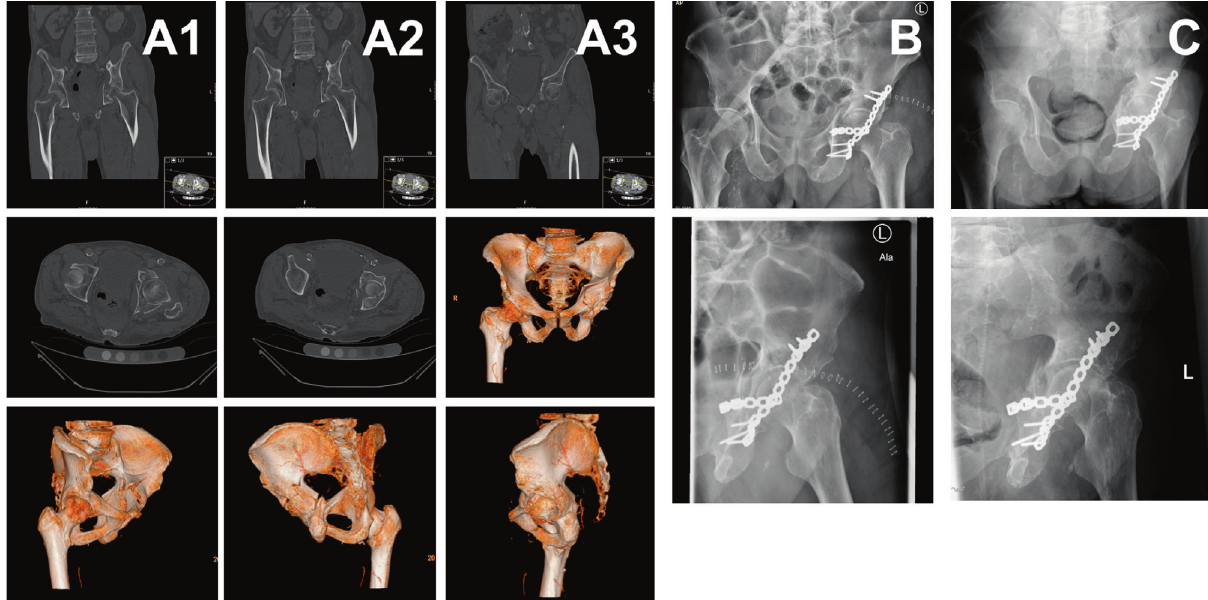
Figure 2. Two-column fracture of the left acetabulum following a bicycle accident in a 76-year-old male. Significant premorbidities included cardiomyopathy with s/p myocardial infarction nine years ago, recurrent DVTs with warfarin anticoagulation, lower limb atherosclerosis with s/p femoro-popliteal bypass, and s/p viral encephalitis with residual impaired gait and presence of suprapubic catheter. Due to s/p multiple abdominal surgeries, the anterior approach was no option. The individualized treatment plan was defined as ORIF via one singular Kocher-Langenbeck approach, aiming to convert the two-column fracture into a stable fracture pattern with secondary congruence of the hip joint. Computed tomography (CT) scans show the two-column fracture in frontal, axial views and 3D reconstruction (column A1–A3), postoperative conventional radiographs display the reduced joint line at two weeks (column B) and at three months follow-up (column C).